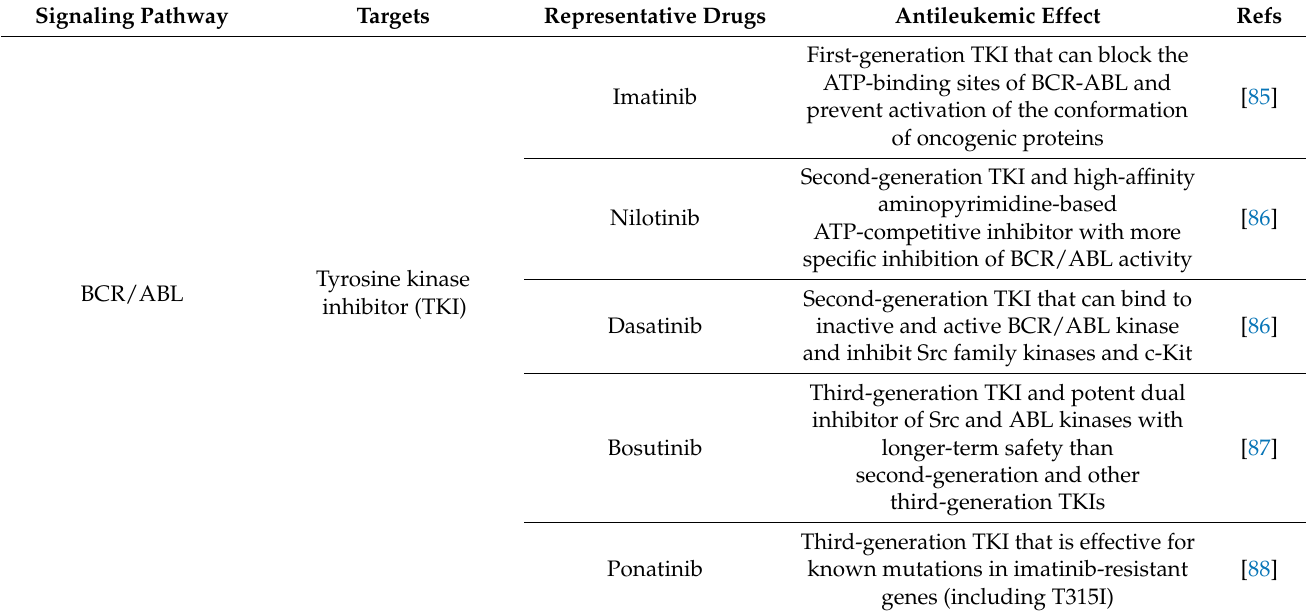
Table 1. ALL redox signaling pathway targets and representative